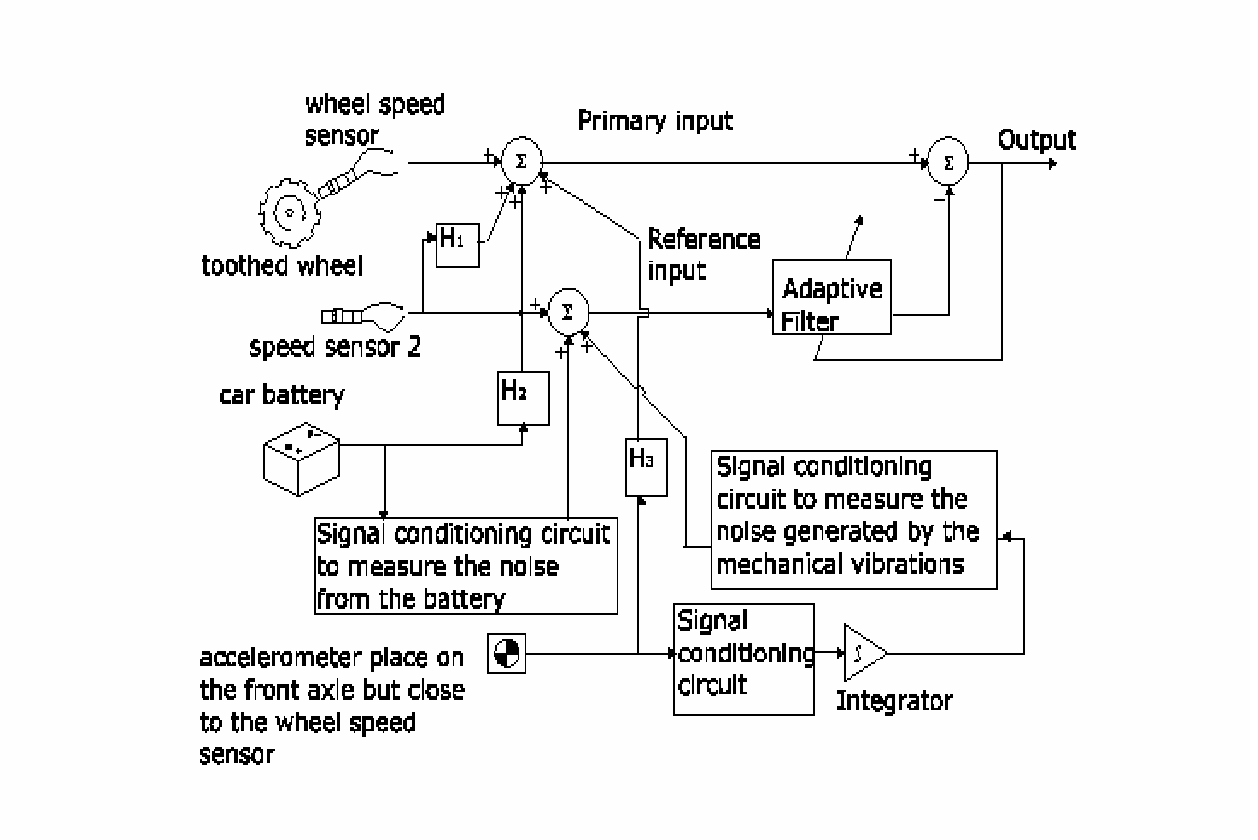
Figure 4. Block diagram of the adaptive noise canceling